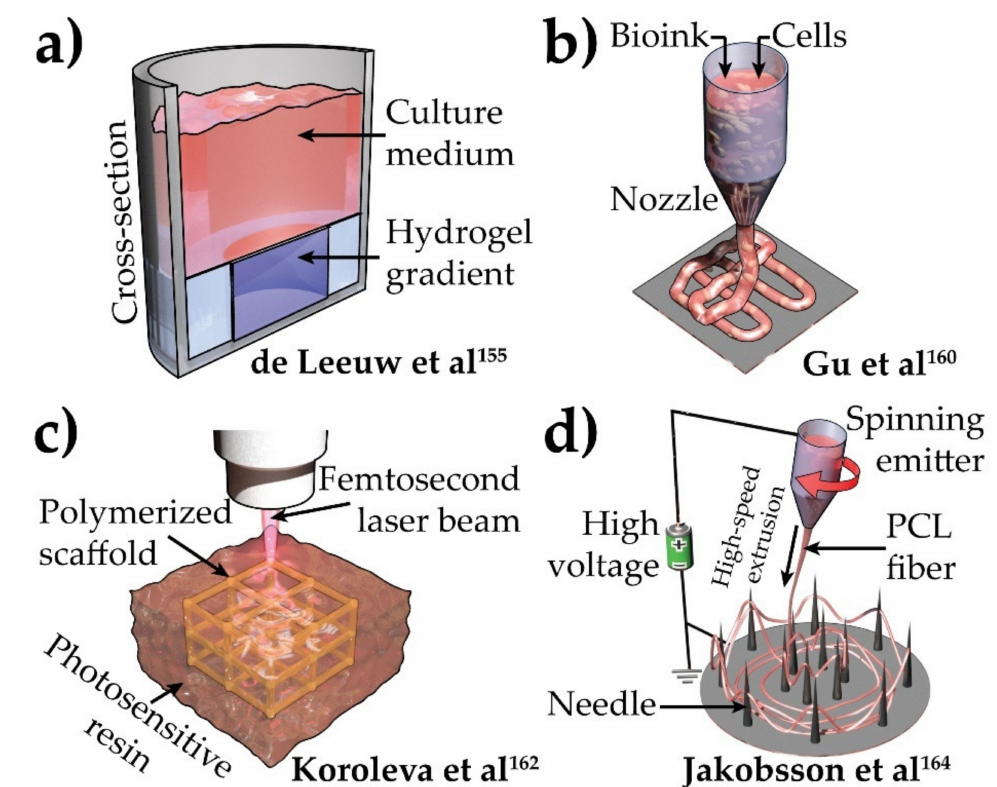
Figure 5. Tentative technologies to be adapted in AD modeling. ( a ) Hydrogel gradient at the bottom of wells of a 96-well plate [155]. ( b ) Three-dimensional (3D) printing [160]. ( c ) Scaffold from femtosecond laser–induced polymerized photosensitive resin [162]. ( d ) Electrospun nanofiber–based scaffold. Cells can be embedded in these scaffolds to create 3D cultures [164]. PCL, poly- ε